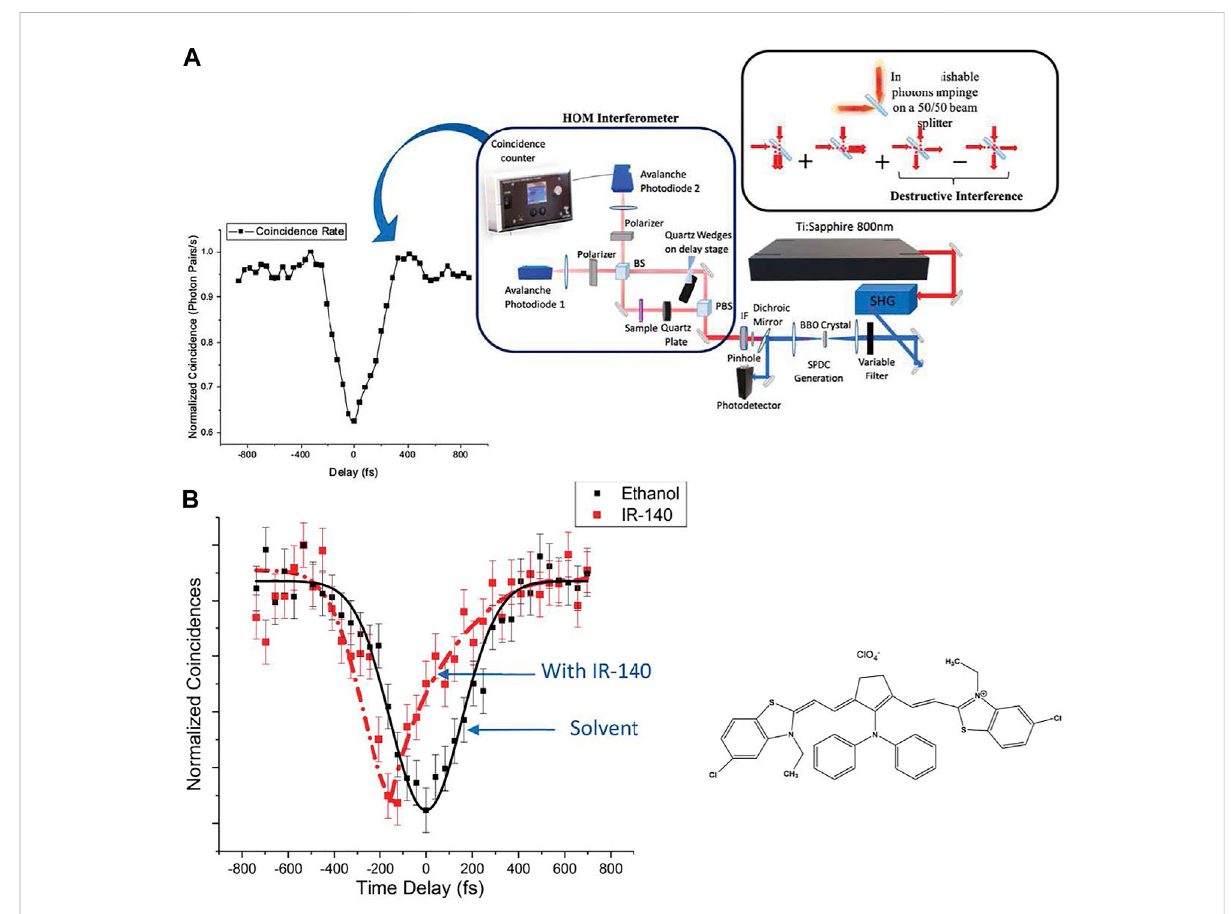
FIGURE 4 (A) Experimental setup for measuring the dephasing time of photons arising from its interaction with a molecular sample by using a HOM interferometer. (B) The presence of a simple refractive or birefringent material in the interferometer pathway can lead to polarization mode dispersionwhichdegradesentanglementandcausestemporaldelaysintheorderof100fs.Asadirectresult,thenormalizedcoincidenceprobability as a function of the scanning time is shifted by a time delay that corresponds to the dephasing time